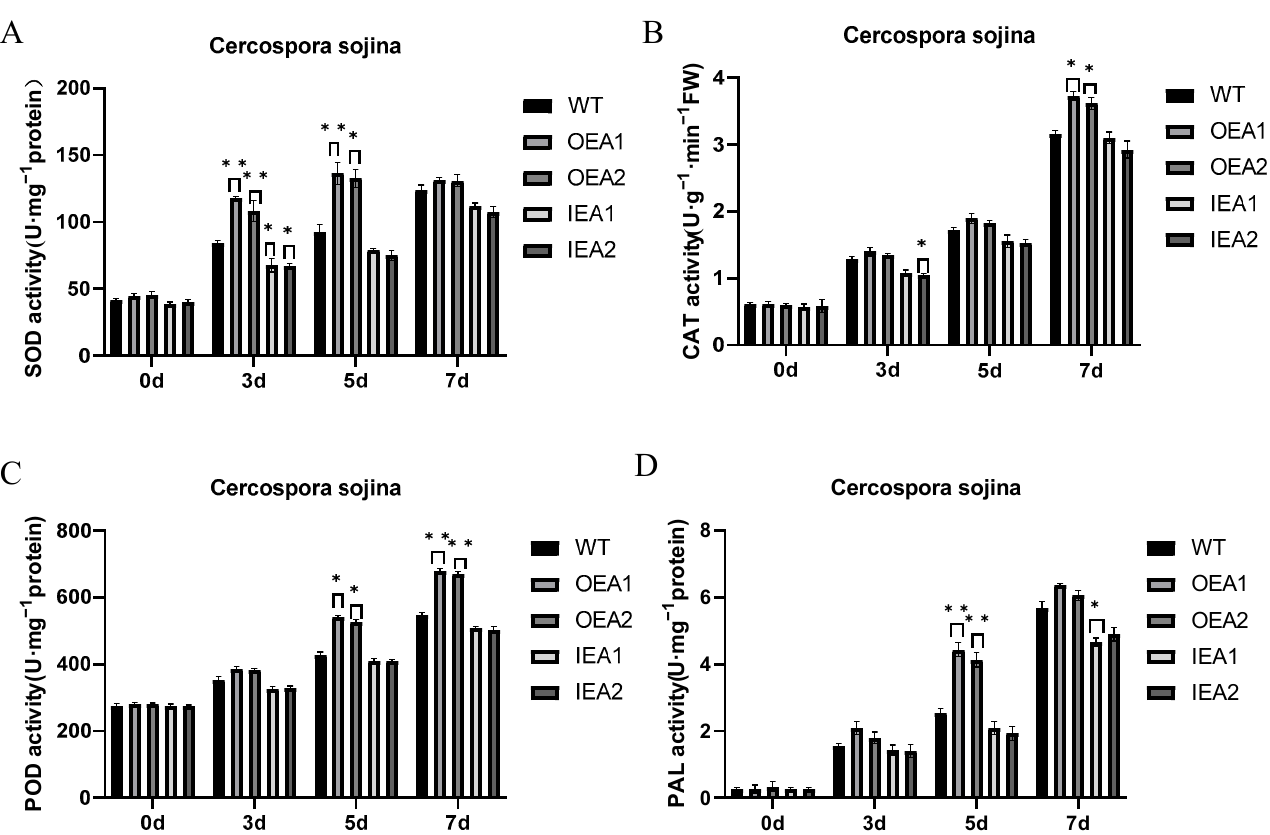
Figure 5. Defense enzyme activities of transgenic soybean lines infected by Cercospora sojina Hara. ( A ) Changes of SOD activity in OEA1-OEA2 overexpression line and the IEA1-IEA2 interference expression line after 0, 3, 5, and 7 days of C. sojina infection; ( B ) Changes of CAT activity in OEA1- OEA2 overexpression line and IEA1-IEA2 interference expression line after 0, 3, 5, and 7 days